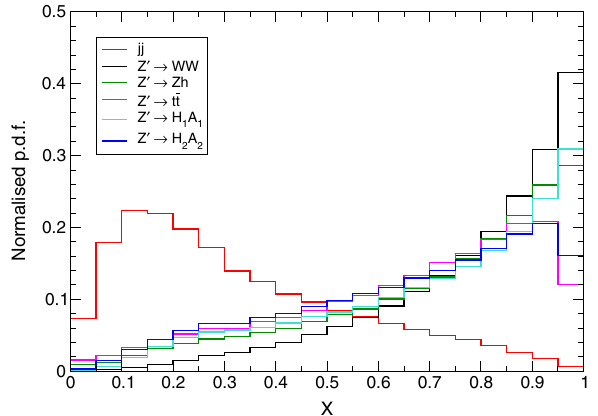
Fig. 6 Left: Distribution of the NN score X for the QCD background and various Z (cid:2) signals